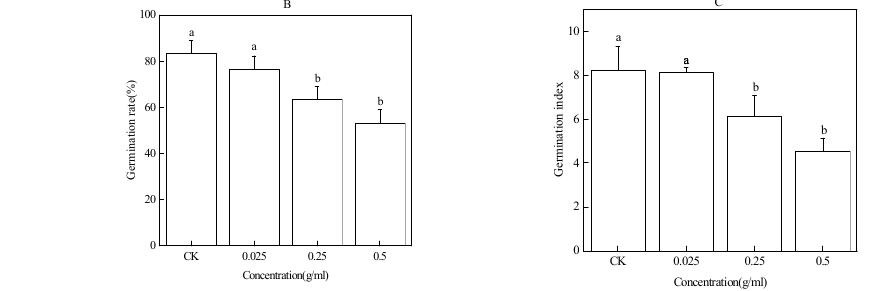
Figure 4. Effect of the water extract of faba bean rhizosphere soil on GE ( A ), GR ( B ), and GI ( C ) of faba bean seeds. Data are presented as the mean ± standard error of three biological replicates. Various letters for each index indicate significant differences at p < 0.05.